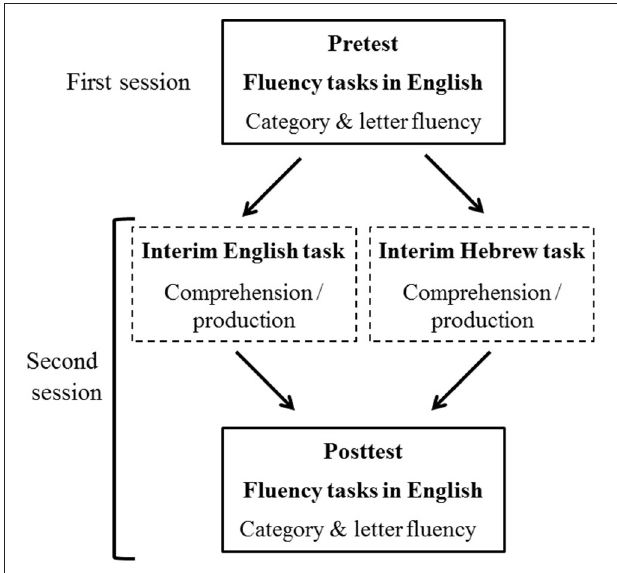
FIGURE 1 | Illustration of the experimental